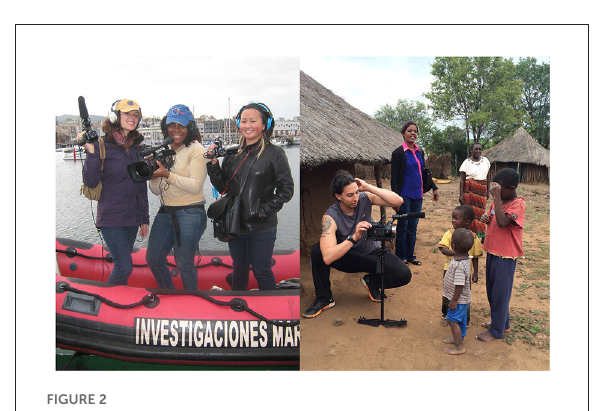
FIGURE2 Undergraduate students from a variety of majors document marine scientists in Spain (left) and document farming families working with agriculture scientists and plant biologists in Zambia (right)